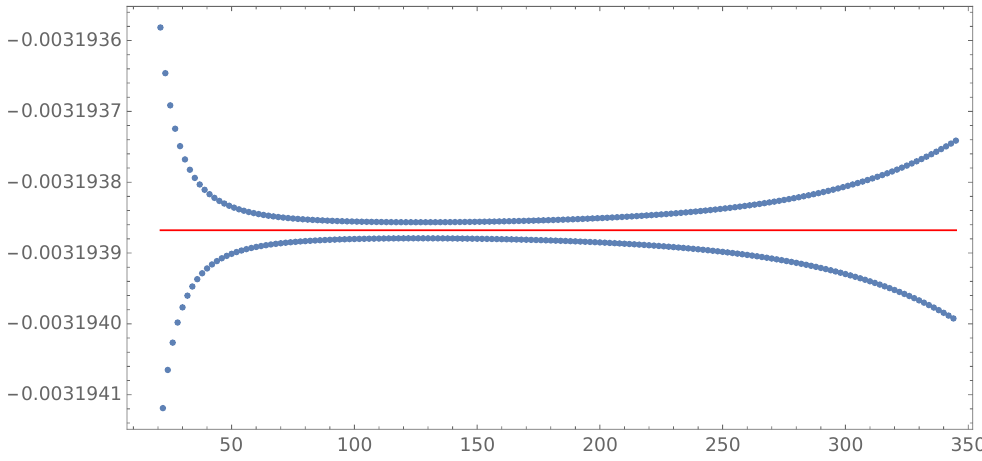
Figure 11 . A plot of the partial sums of Im I ( t (cid:3) ), for (cid:20) = 1, up to order q n for 20 (cid:20) n (cid:20) 350. The expected value is shown in